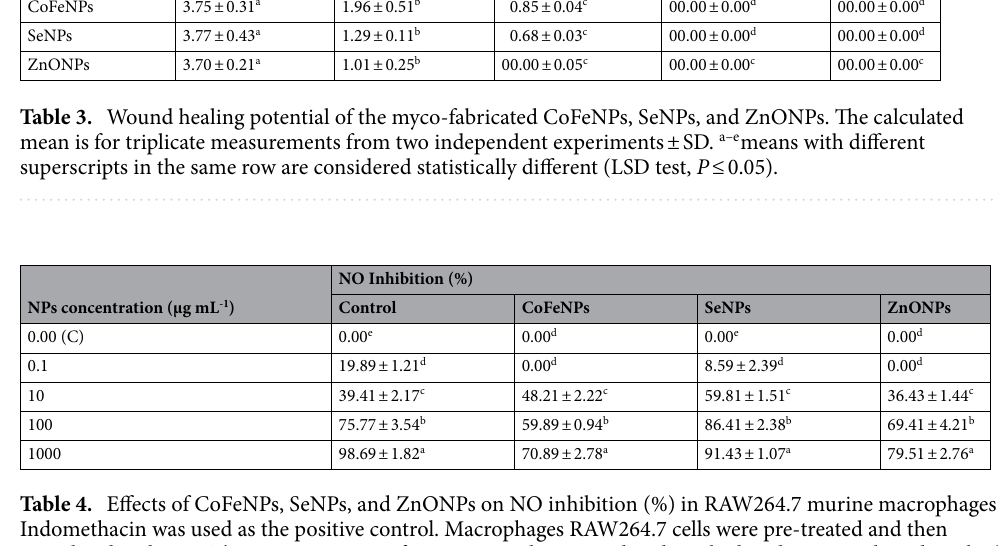
Table 4. Effects of CoFeNPs, SeNPs, and ZnONPs on NO inhibition (%) in RAW264.7 murine macrophages. Indomethacin was used as the positive control. Macrophages RAW264.7 cells were pre-treated and then stimulated with LPS. The concentrations of Nitrite were determined as described in the materials and methods. The calculated mean is for triplicate measurements from two independent experiments ± SD. a–e means with different superscripts in the same column are considered statistically different (LSD test, P ≤ 0.05).